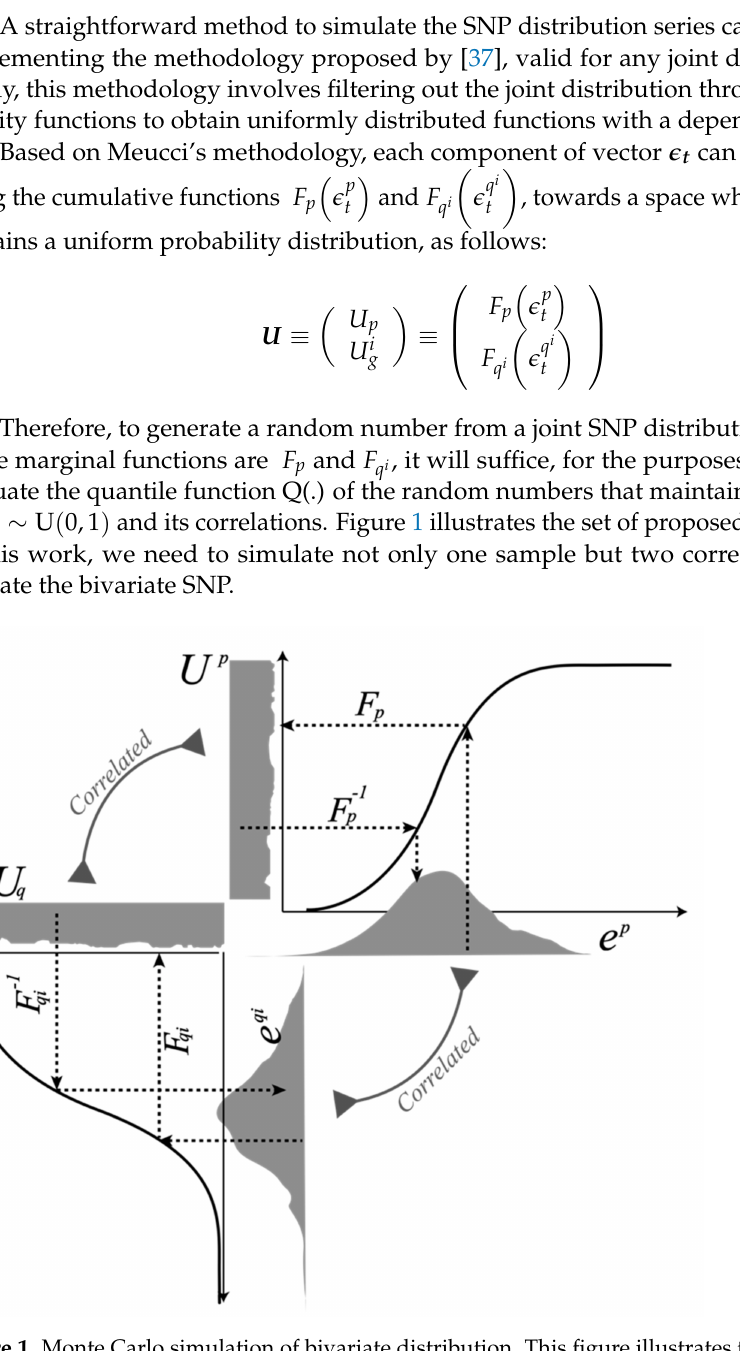
Figure 1. Monte Carlo simulation of bivariate distribution. This figure illustrates the method used to simulate random numbers based on